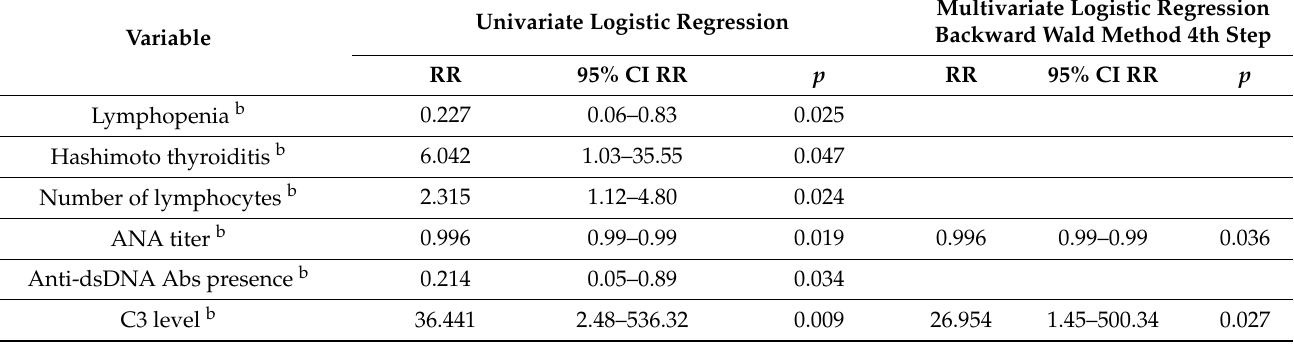
Table 5. Predictors of transition from active to latent EBV infection in 24 SLE patients with active EBV infection at enrollment.